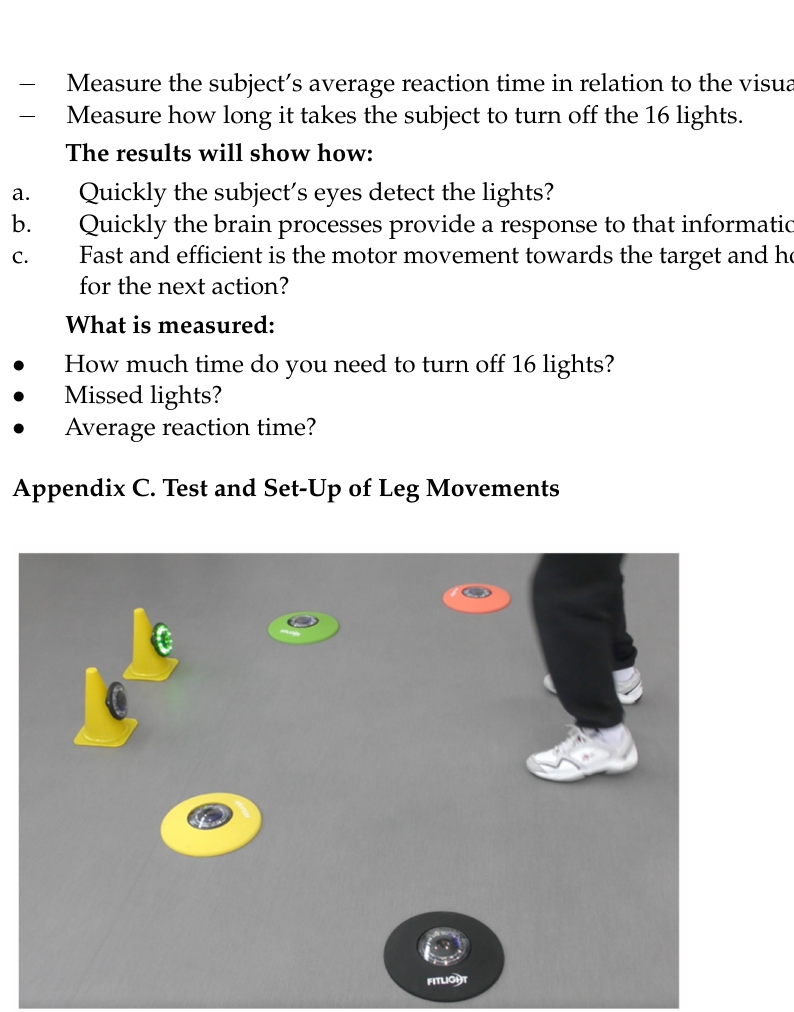
Figure A3. FitLight ® s embedded in colored rings on the floor. Subjects stand in between to dampen a light by moving a leg over it. The experimental set-up and specification are as